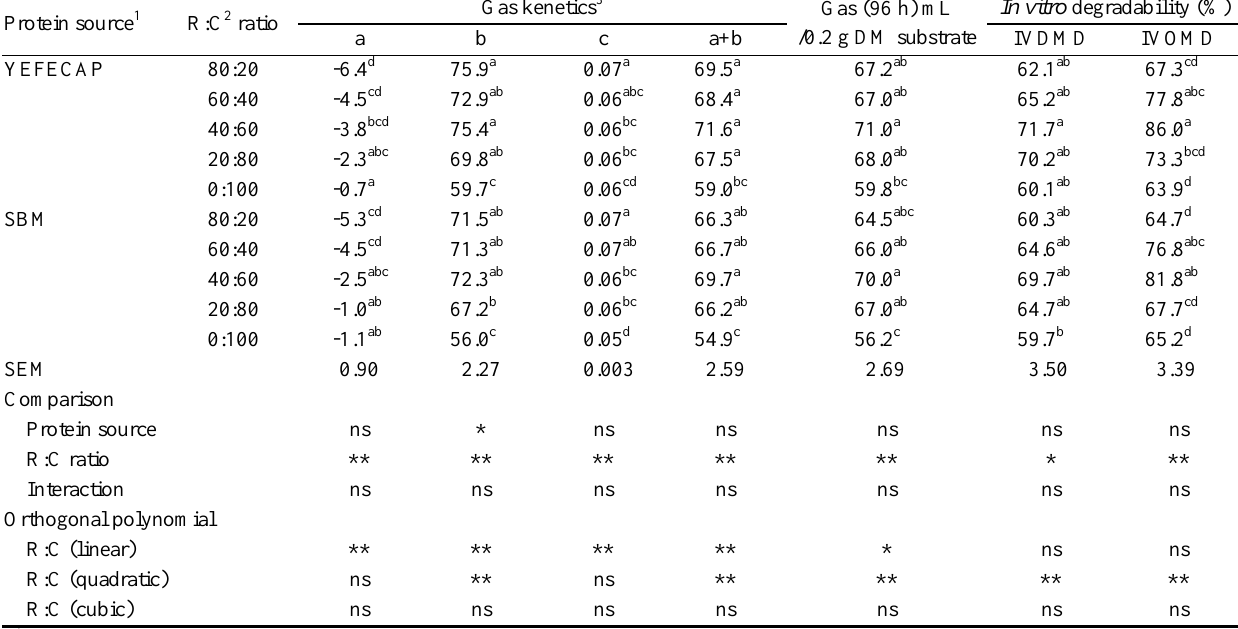
Table 2. Effect of protein source with roughage to concentrate ratio on gas production kinetics and degradability from in vitro incubation with rumen fluid Protein source 1 YEFECAP